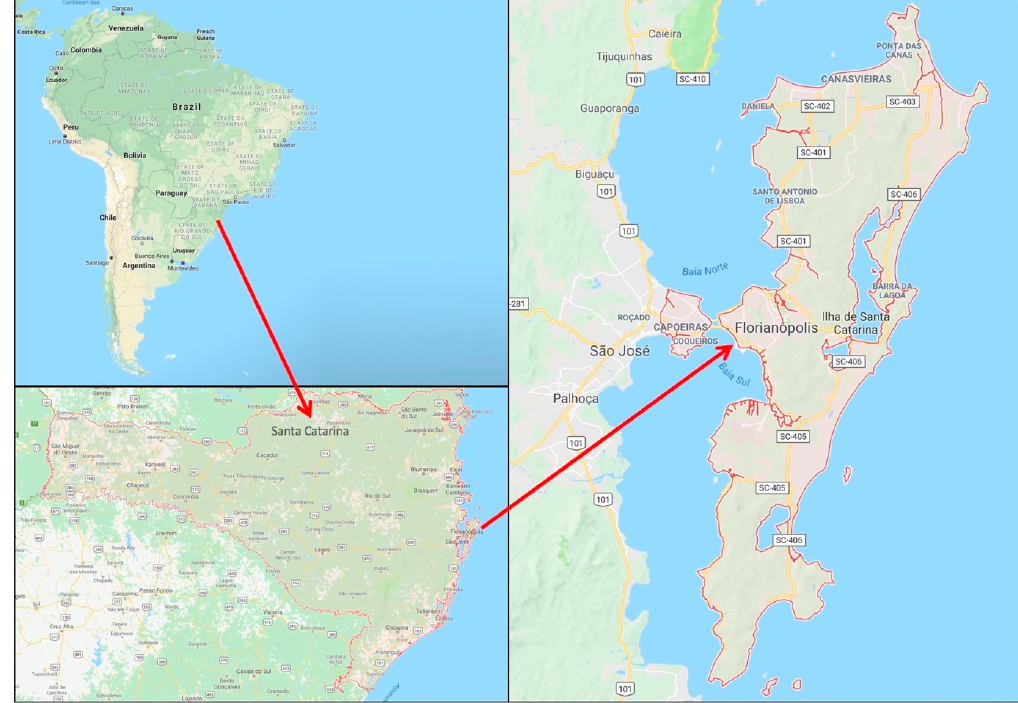
Figure 1. Location of Florianópolis, drawn by authors on a Google Map base map [36].